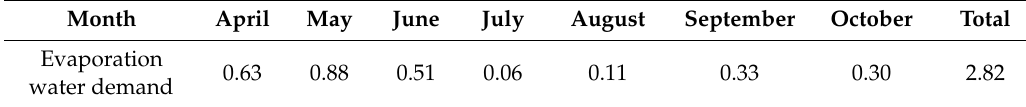
Table 3. Evaporation water demand of the study area from April to October (10 6 m 3 ).